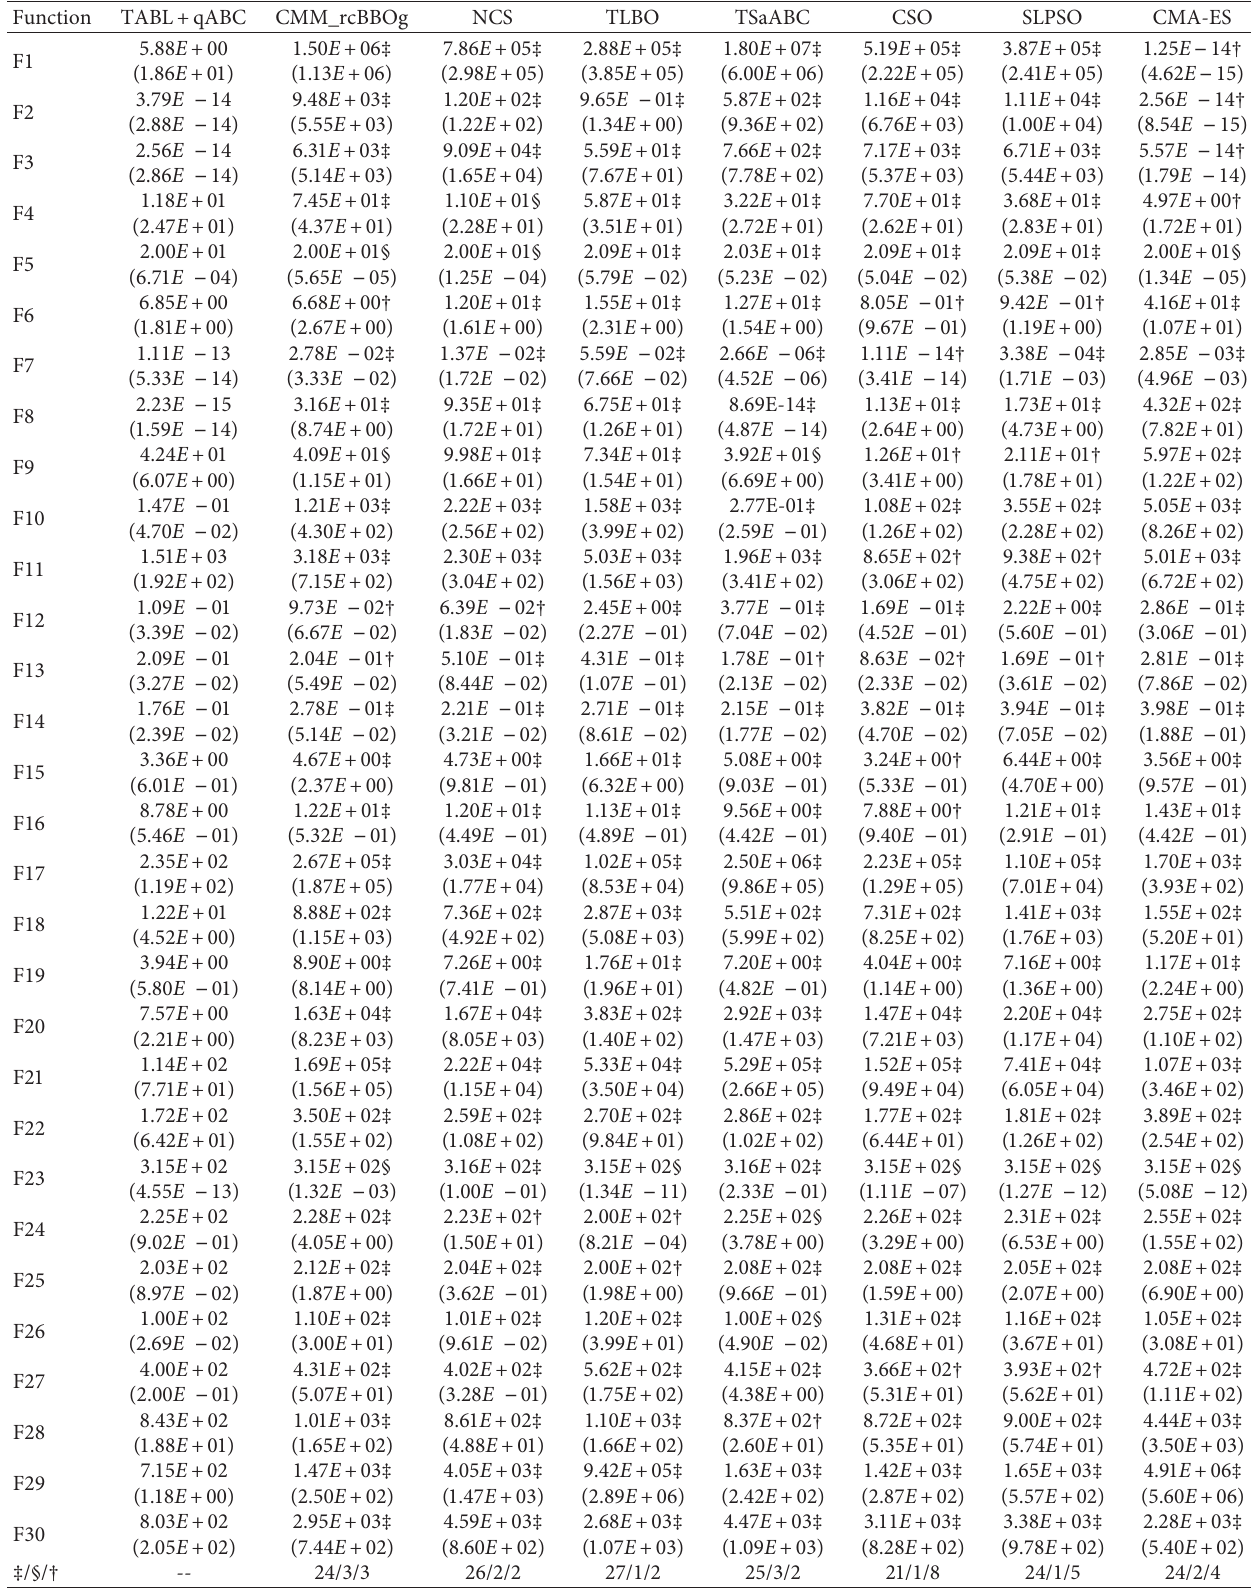
Table 9: The statistical results (mean (std)) of CMM_rcBBOg, NCS, TLBO, TSaABC, CSO, SLPSO, and CMA-ES over 51 independent runs on the CEC2014 benchmarks with 30 D